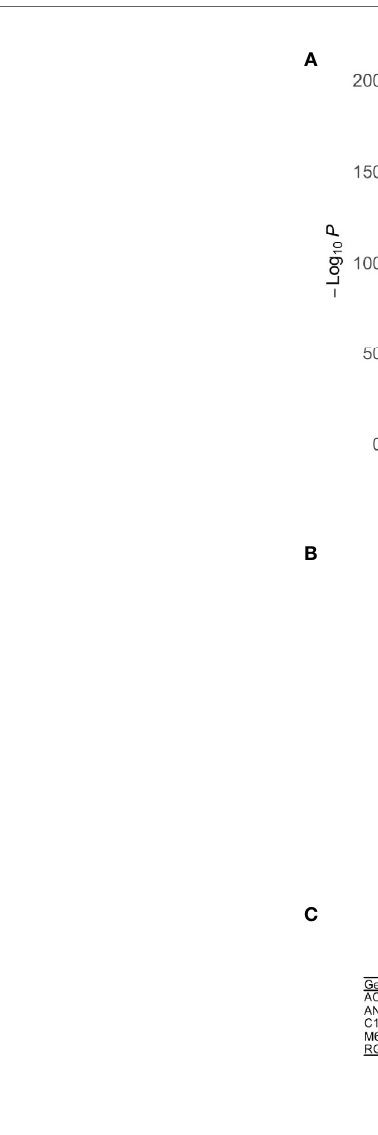
FIGURE 3 | A gene signature using in fi ltrated CD8+ T cells. (A) A volcano plot of the differentially expressed genes (DEGs) between HPV+ and HPV − HNSCC tumor-in fi ltrated CD8+ T cells. (B) A volcano plot showing the DEGs obtained from Cox regression analysis of survival-related HPV+ HNSCC-in fi ltrated CD8+ T cells. (C) Forest plot lines of the top 4 genes screened by using random survival forest analysis of HNSCC